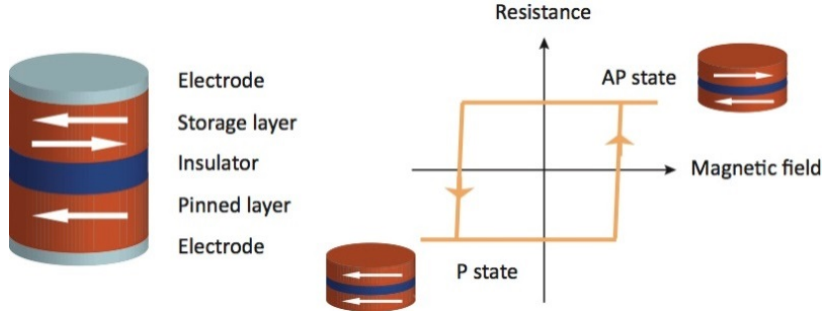
Figure 1. The magnetic tunnel junction (MTJ) consists of a storage layer and a pinned layer (separated by the insulator layer MgO). MTJ resistance is dependent on the orientation of MTJ magnetization with the parallel (P) and antiparallel (AP) states. The switching is operated by adjusting the magnetic field.